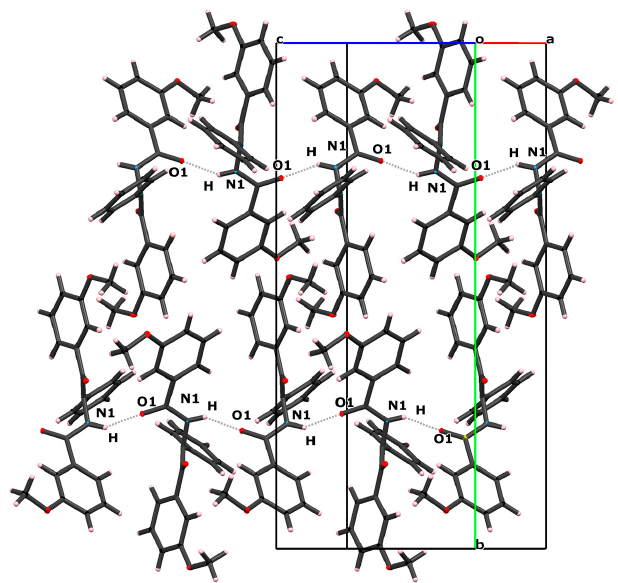
Table 1. Selected hydrogen bond parameters of ( 1 ) (Å, °).